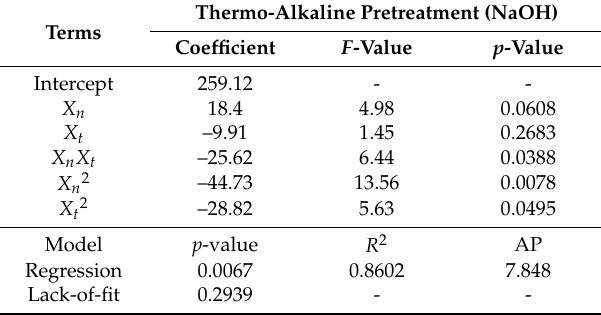
Table 5. Statistical significance of the model coefficients for predicting the response of the methane yield